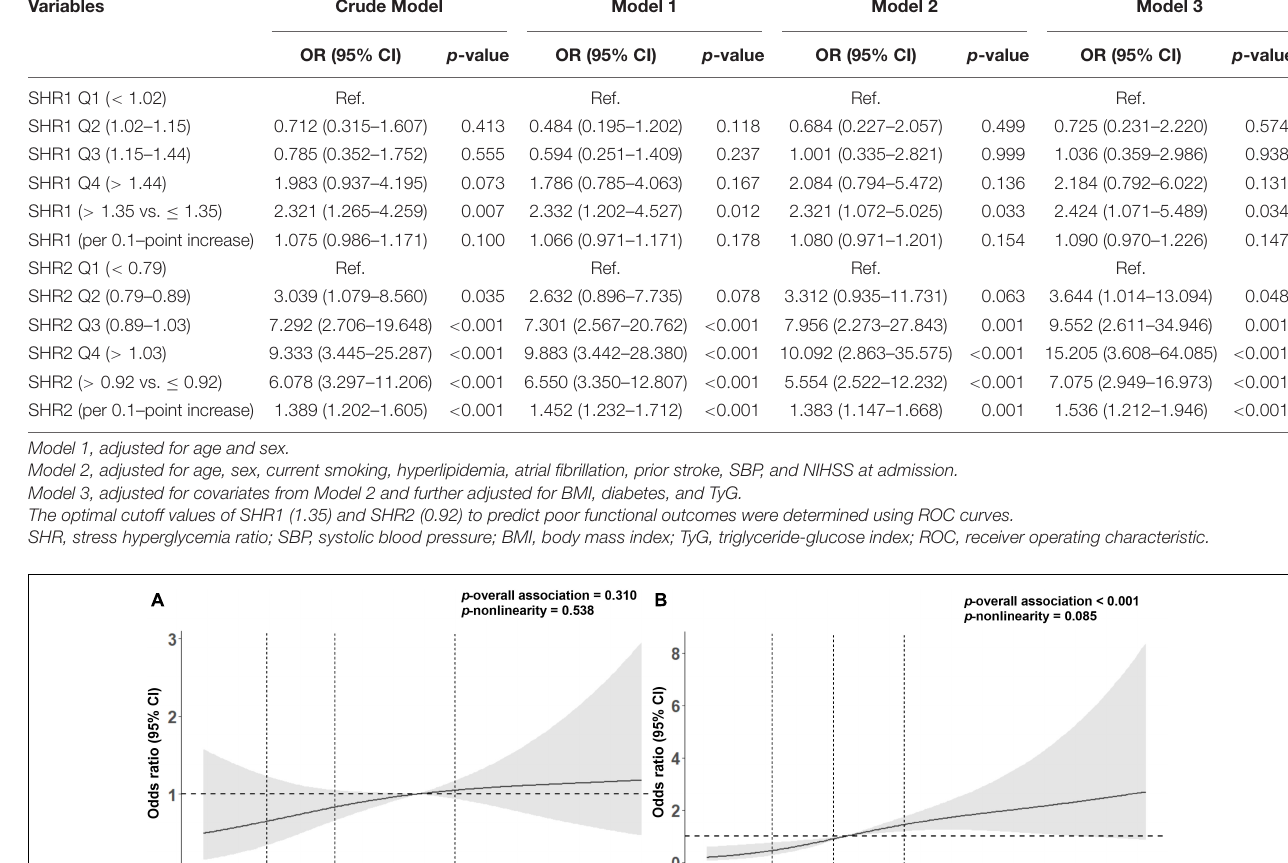
TABLE 2 | Univariate and multivariate logistic regression analyses for 3-month poor functional outcomes. Variables